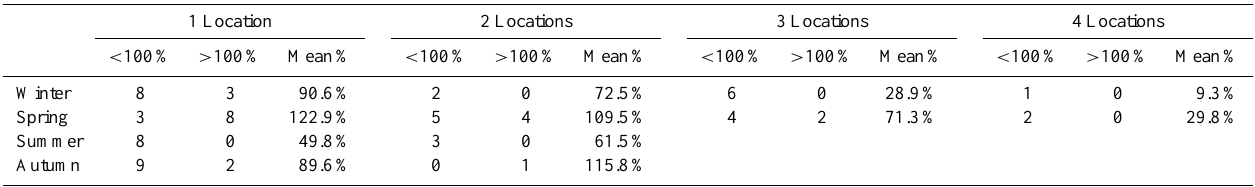
Table 2. Columns 1 and 2 include the number of years when a rogation is celebrated when less ( < 100%) or more ( > 100%) precipitation than long term precipitation mean value. Column 3 includes precipitation mean anomaly in Barcelona for years with rogations celebrated simultaneously in 1 to 4 locations (Gerona, Barcelona, Tarragona and Tortosa). Anomalies are computed as percentages with respect to the average value of the period 1786–1850.